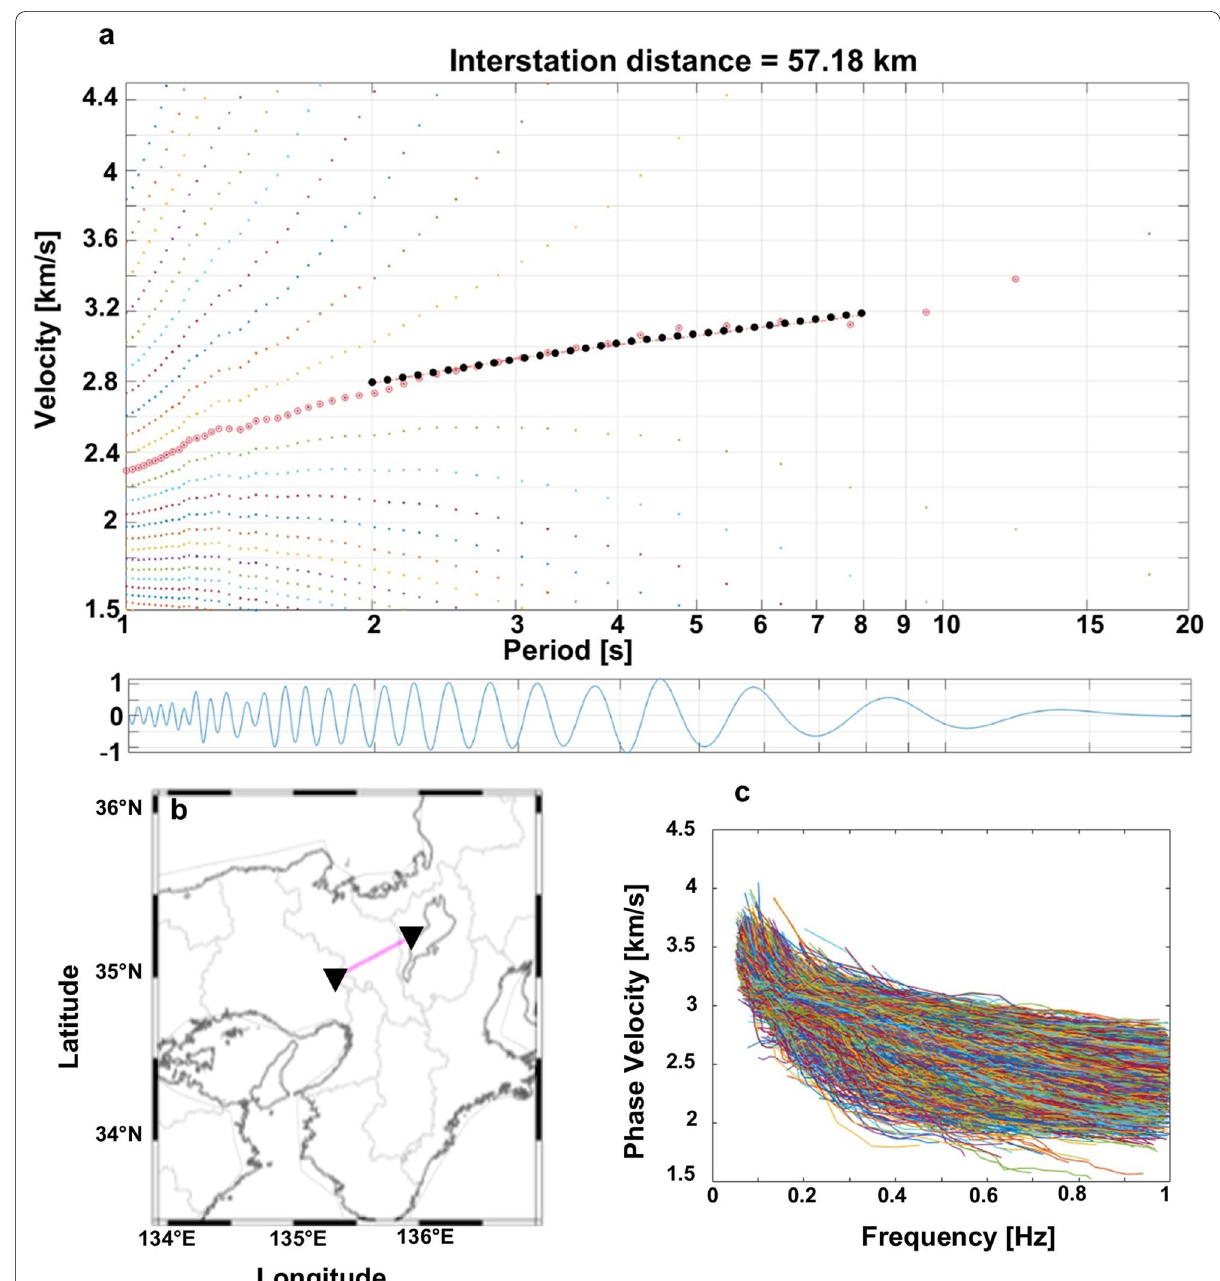
Fig. 3 a Observed phase velocity dispersion curves (upper panel) and the real part of the cross-correlation spectrum (lower panel). Red and black circles in the upper panel represent the selected points of the dispersion curve and the average phase velocity dispersion curve for the region, respectively. b Location of the station pair for which dispersion data are displayed in panel a . c Phase-velocity–frequency plot showing the 23,647 selected dispersion curves for all the station pairs